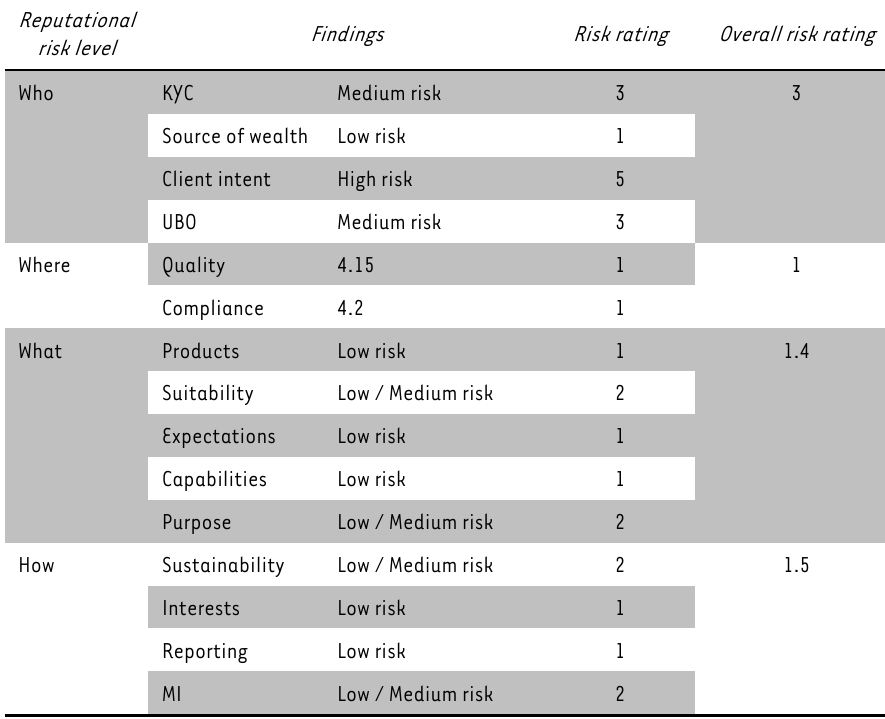
TABLE 9: Four-point reputational risk matrix